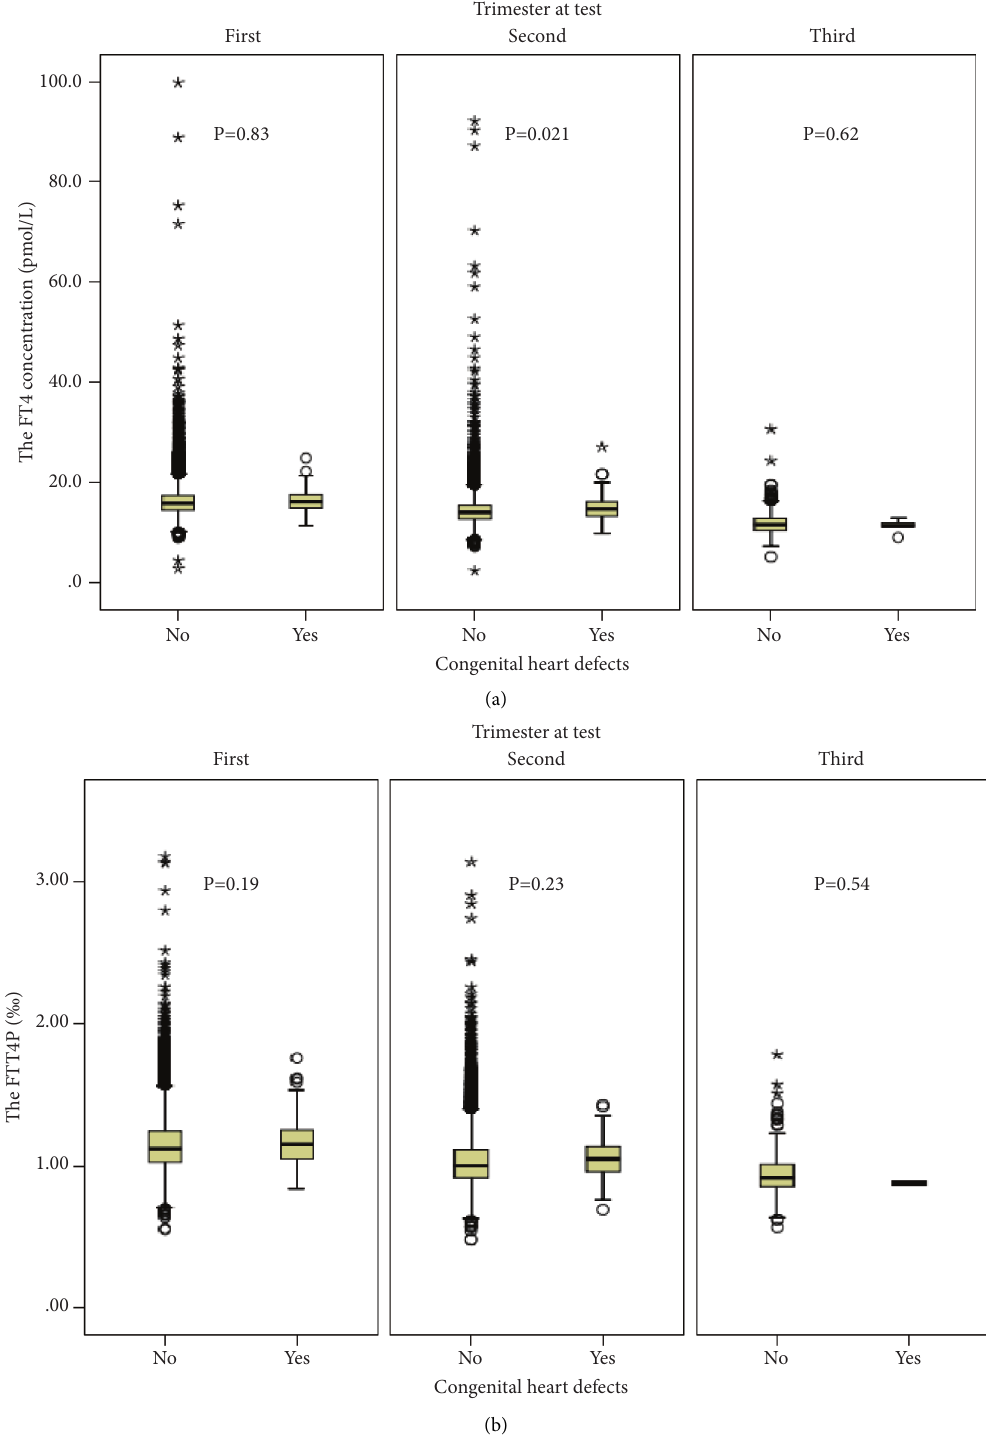
Figure 2: Maternal free thyroxine (pmol/L) and the free-to-total thyroxine proportion (%) between women whose infants had and did not have congenital heart defects by the trimesters at the thyroid function test. Abbreviations: FT4, free thyroxine and FTT4P, free-to-total thyroxine proportion. (a) The free thyroxine and (b) the free-to-total thyroxine proportion. The bottom and top edges of each box represent the first (P25) and third quartiles (P75), respectively. The band within the box represents the median (P50), and the whiskers represent values that are 1.5 times the interquartile range. P values for the Mann–Whitney U